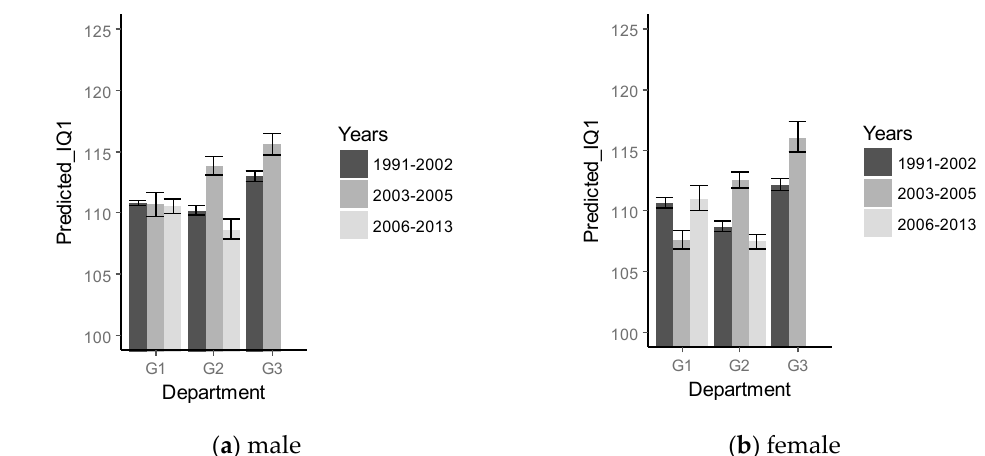
crease in the P2 period. In the G3 group, there was no significant increase in mathematical